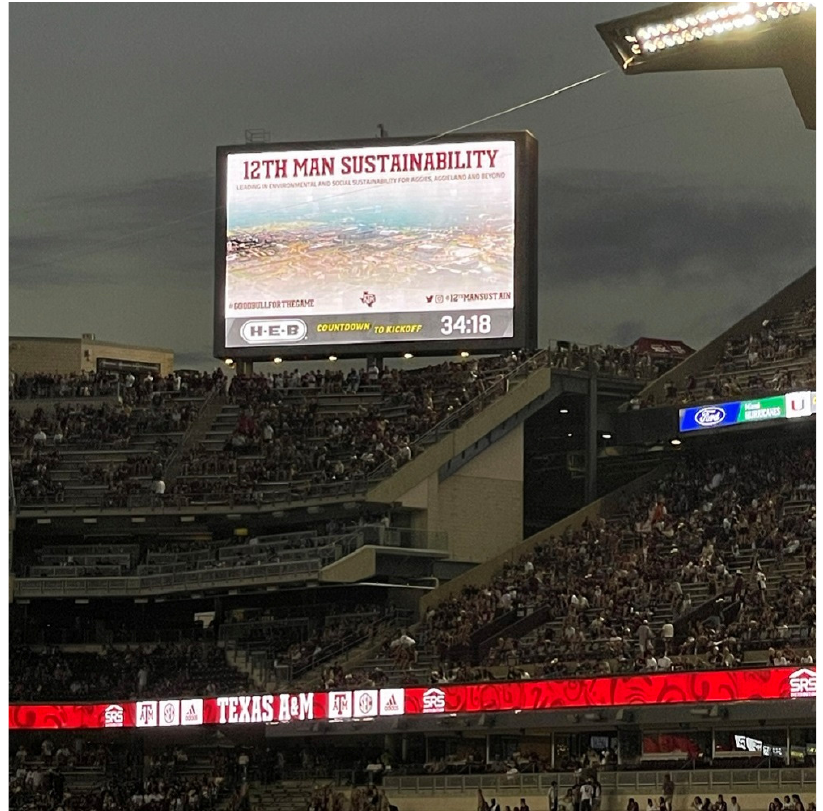
Figure 2. Kyle Field Screen Board: 17 September 2022, Texas A&M v. University of Miami at Kyle Field, College Station, Texas, USA (Source: K. Wellman).